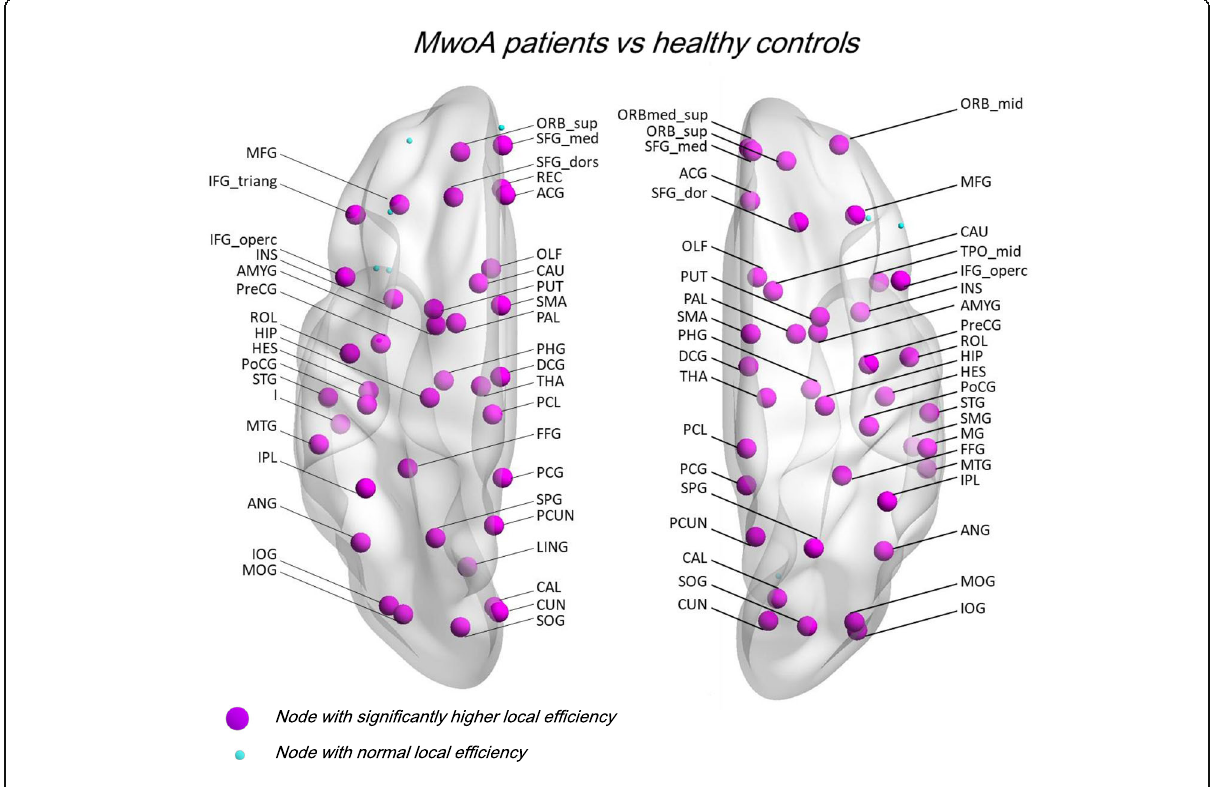
Fig. 1 Representation of nodes with significantly higher local efficiency ( t score) in MwoA patients compared to HC data sets ( p < 0.05 corrected for multiple